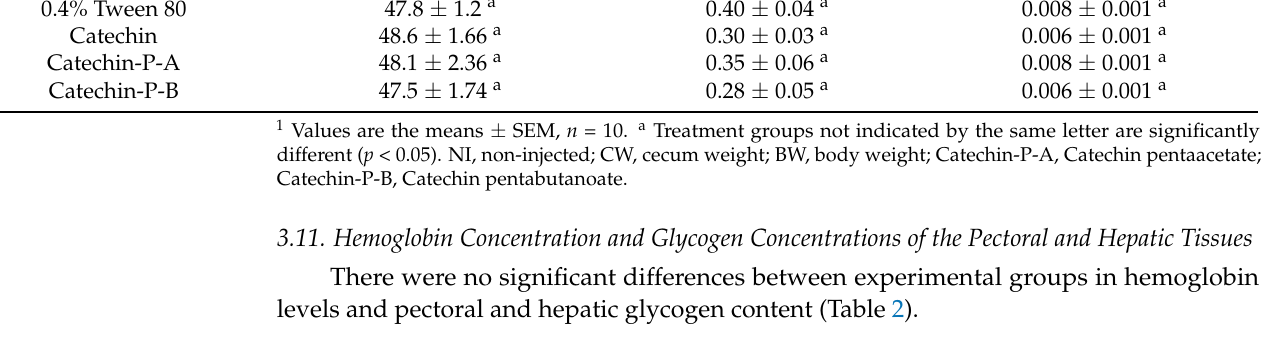
Table 2. Hemoglobin, concentrations (g/dL) 1